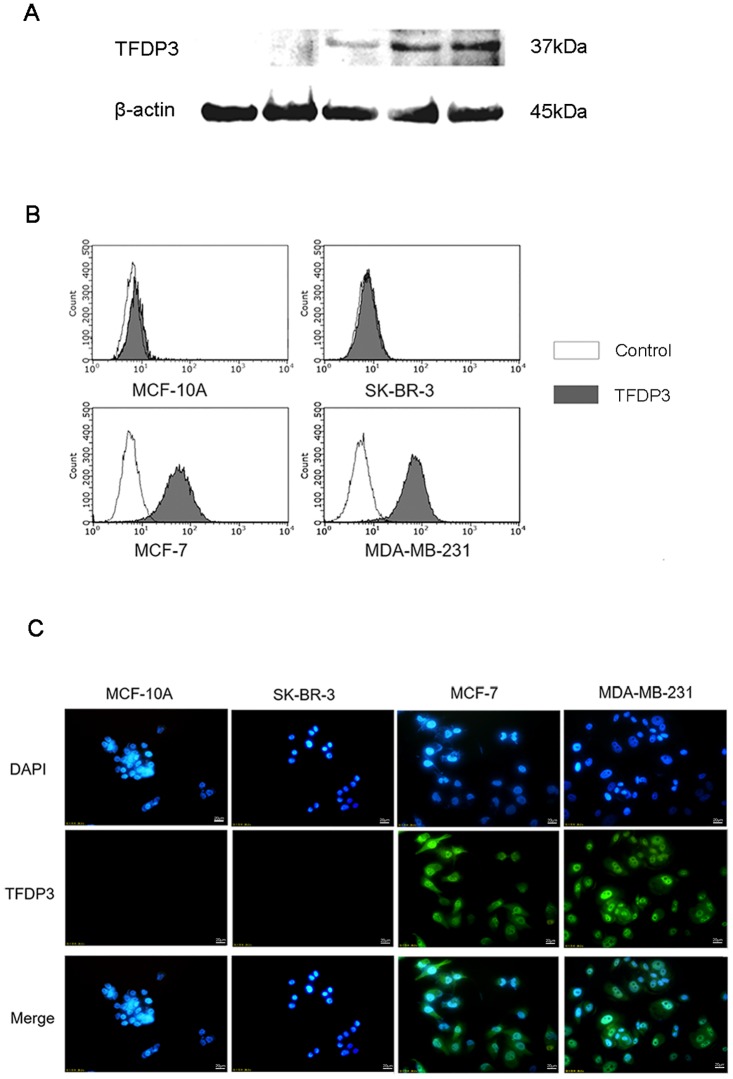
TFDP3 expressions in breast cancer cell lines and testicular tissue.A, Western Blot was used to detect TFDP3 expression in four breast cell lines and testis; B, TFDP3 expression was detected by flow cytometry in both cell lines; C, the subcellular localization of TFDP3 in breast cancer cell line MDA-MB-231 (200×). The expression of TFDP3 in MDA-MB-231 cells was detected both in nuclear and cytoplasm. TFDP3 was green-fluorescence stained and nuclei were stained blue by DAPI.